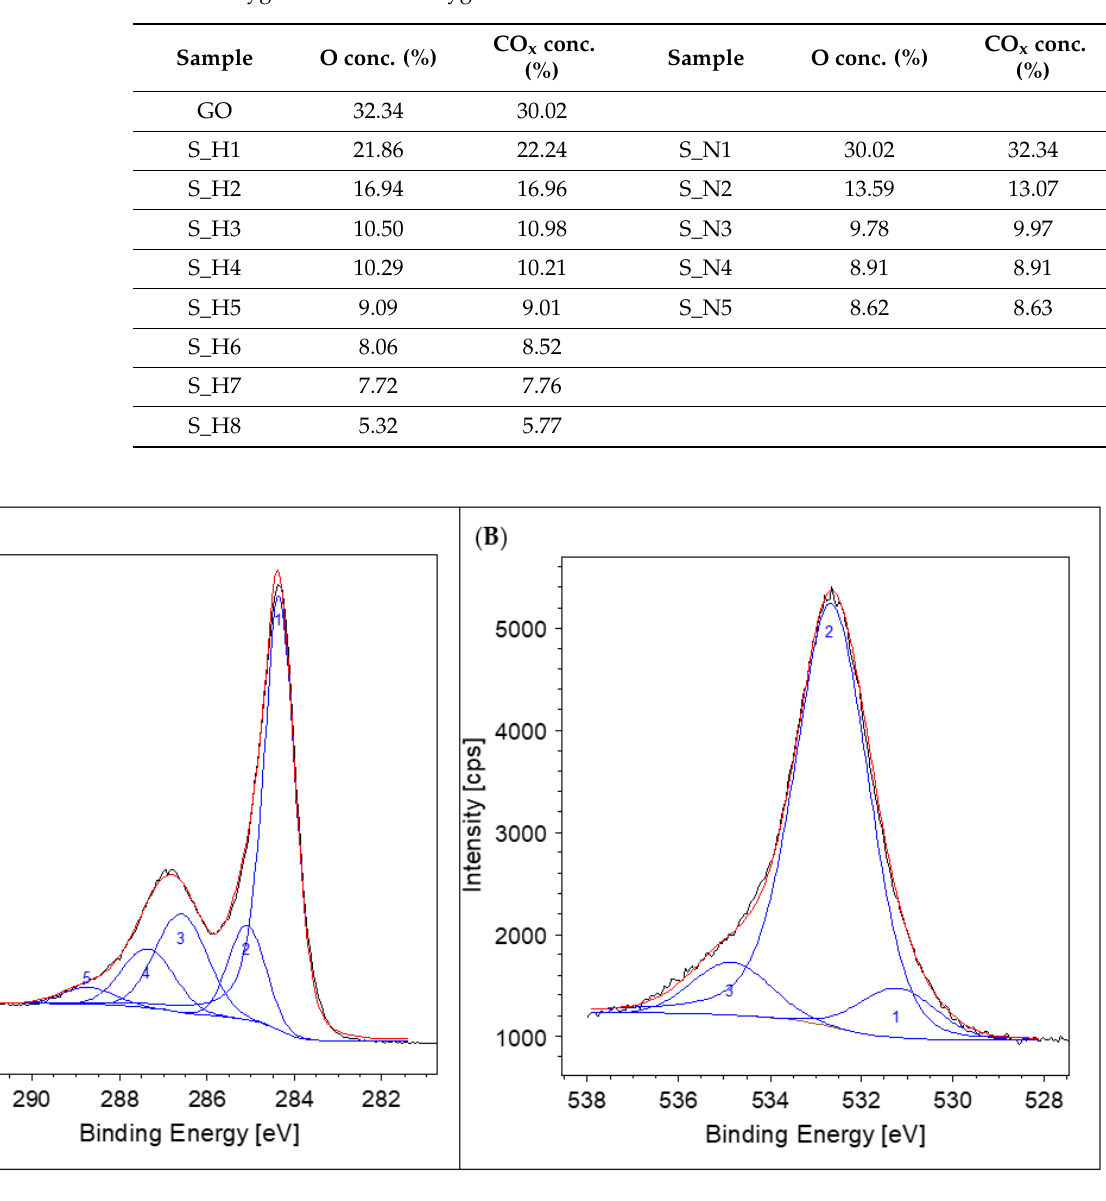
Figure 2. ( A ) C 1s and ( B ) O 1s core-lines of the S_H2 sample reported together with their peak